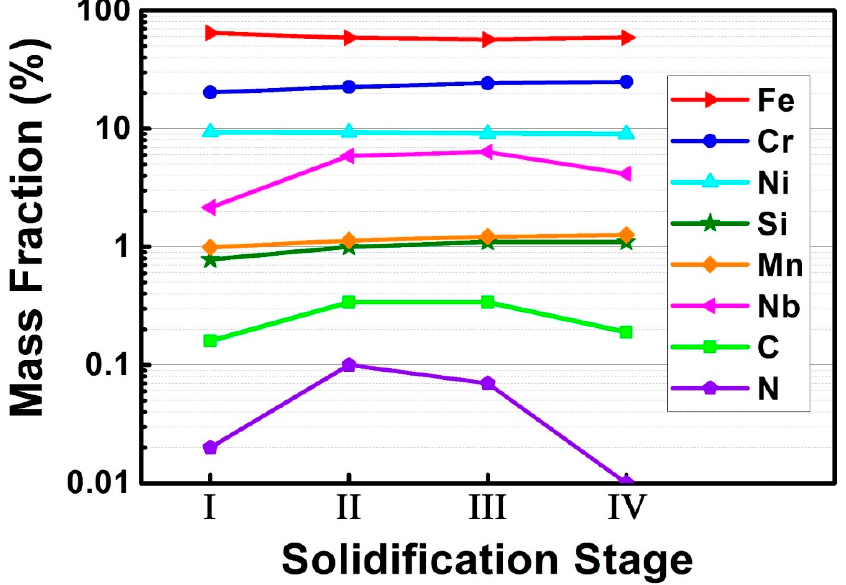
Figure 10. Chemical composition of the liquid phase in different solidification stages marked by red circles in Figure 6b under the withdraw rate of 50 µ m/s, quantitatively measured by field emission electron probe microanalyzer (FE-EPMA).